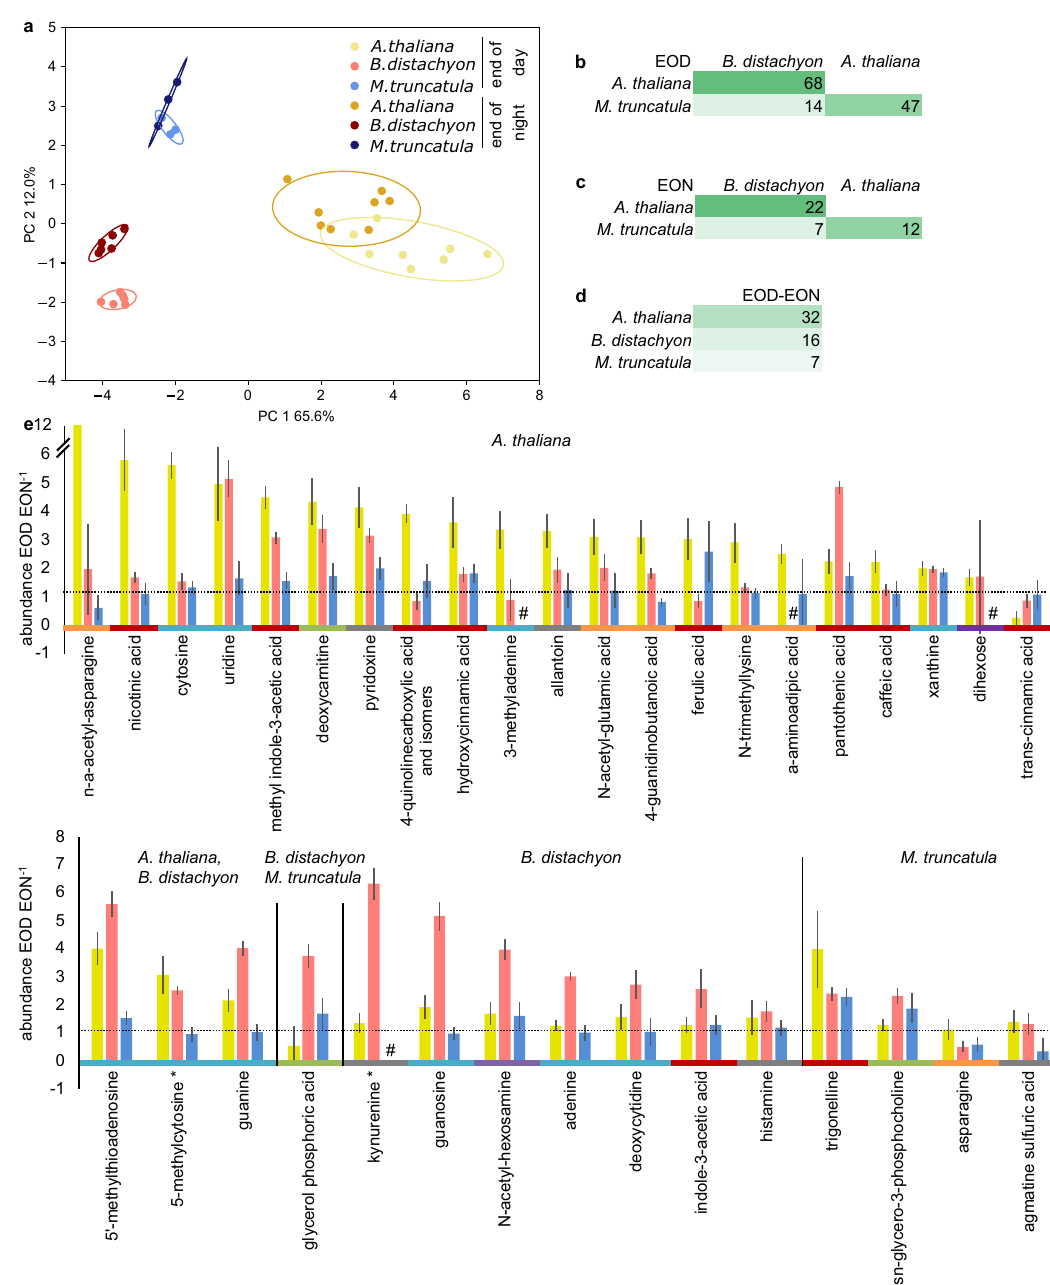
Fig. 5 | Diurnal changes in exudate pro fi les. a Principal component analysis of A. thaliana (yellows), B. distachyon (reds) and M. truncatula (blues) exudate meta- bolites at the end of day(EOD) and end of night(EON).Percentofmetabolites that are signi fi cantly different between species at end of day b , end of night c , and for each species between end of day and night d . Colored by high (dark green) to low (light green) intensity. e Fold difference of metabolites signi fi cantly increased in endofdayvs.endofnight A.thaliana (yellow,topgraph),in B.distachyon (red), M. truncatula (blue), or in two species (bottom graph, indicated in subtitles). One